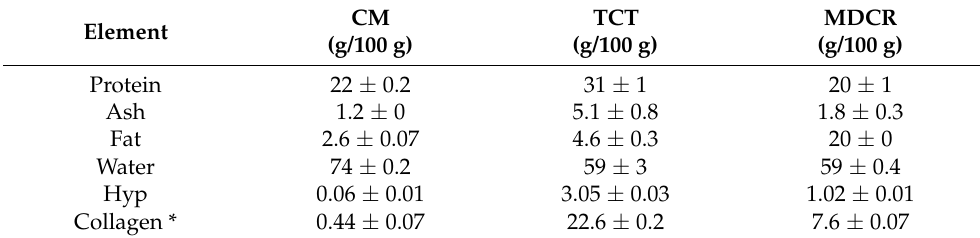
Table 2. Chemical composition, Hyp and estimated collagen content of raw materials used